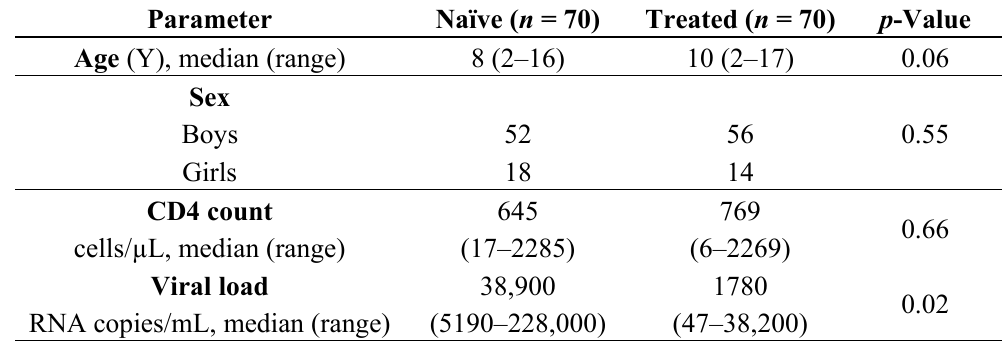
Table 2. Demographic and Clinical Data of HIV-1-Infected Indian